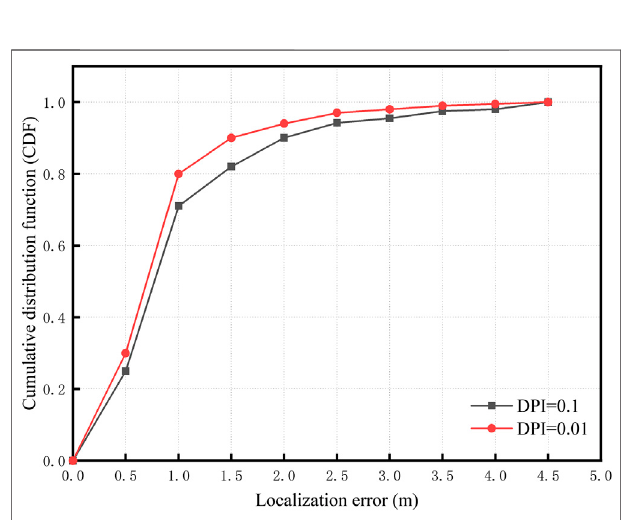
Figure 9 showed that the data was collected by two algorithm was used, the median positioning error of the FM monitoring was 0.7 m. Compared with the fi eld strength meter, the median positioning error was smaller